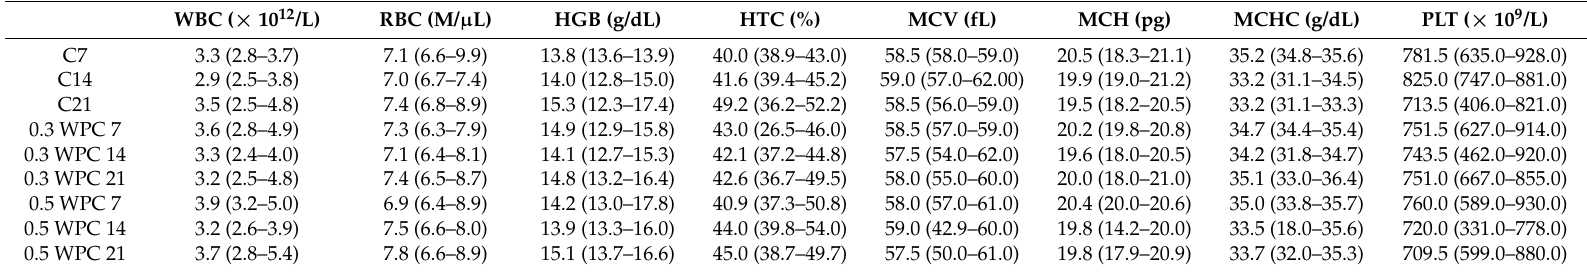
Table 2. Complete blood counts in rats fed with WPC-80 and the controls [median (minimum-maximum)].